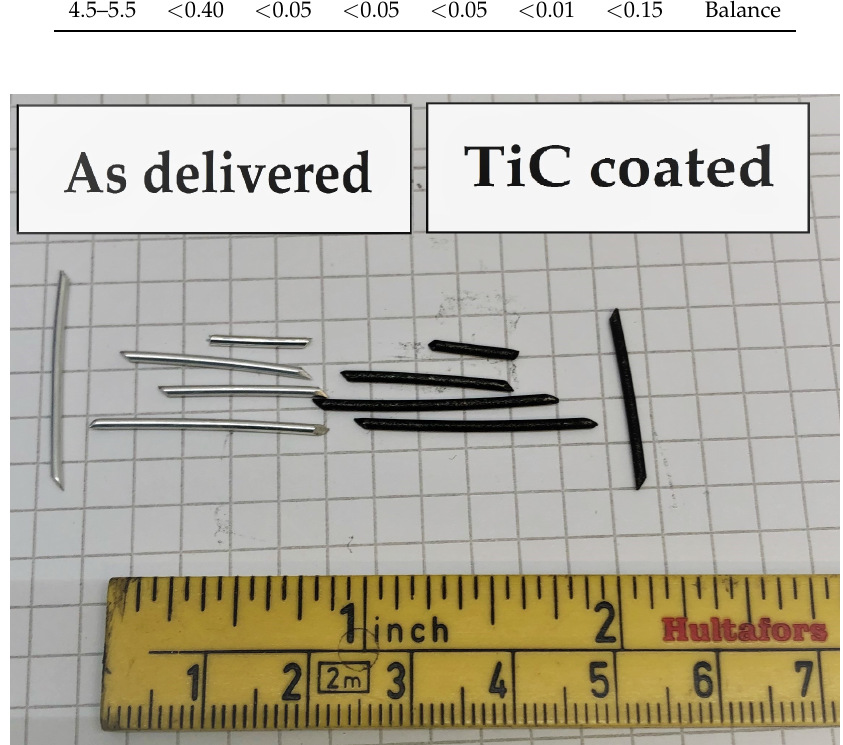
Figure 3. AA4043 granules before (left) and after dry coating (right) with titanium carbide